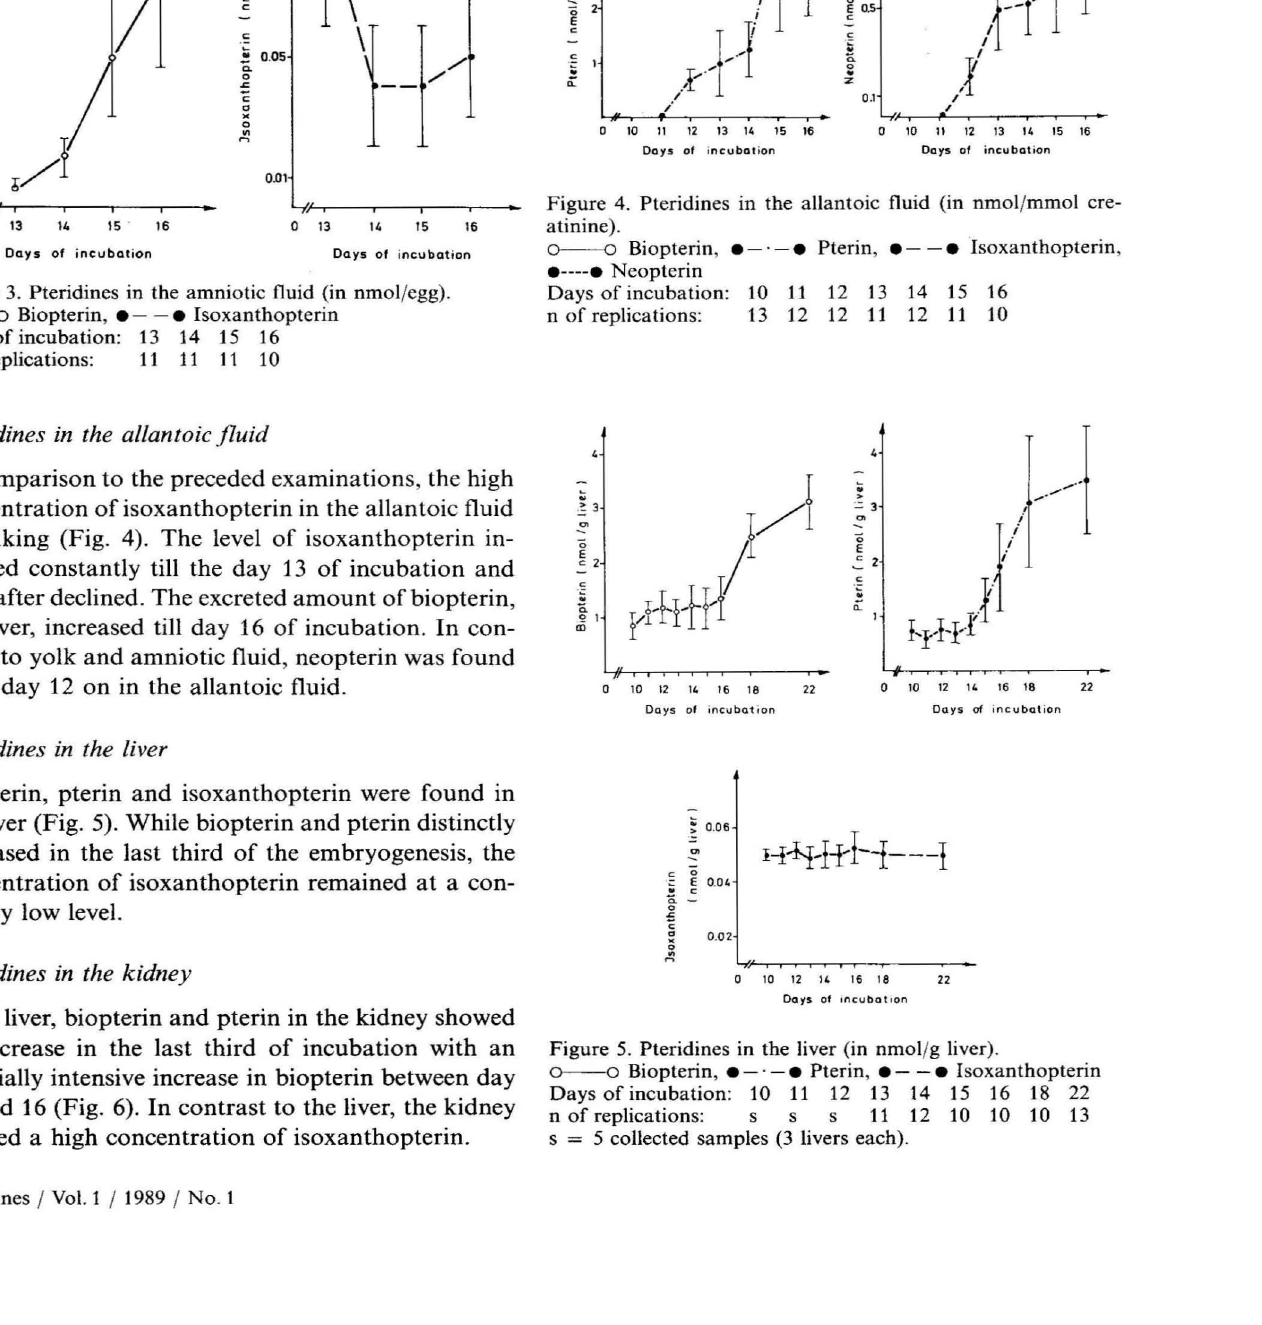
Figure 4. Pteridines in the allantoic fluid (in nmol/mmol cre atinine). 0 - - 0 Biopterin, • -' -. Pterin, • - -. Isoxanthopterin, .----. Neopterin Days of incubation: 10 11 12 13 14 15 16 n of replications: